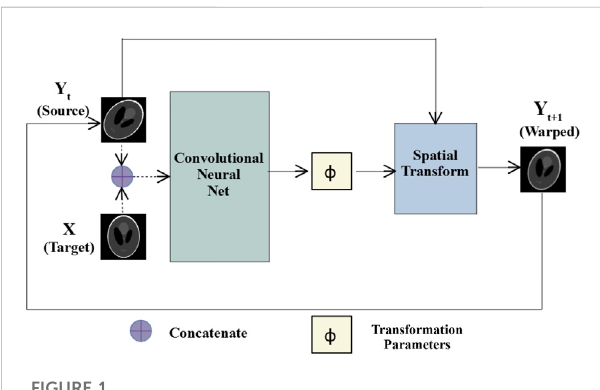
FIGURE 1 Multi-step af fi ne registration network: Initially, source and target images are concatenated and passed as input to a convolutional neural network. The network predicts transformation parameters that are passed along with the source images to a spatial transform layer. The layer generates warped images, which at the next step are passed as the source images to the same network, and the process repeats for k number of